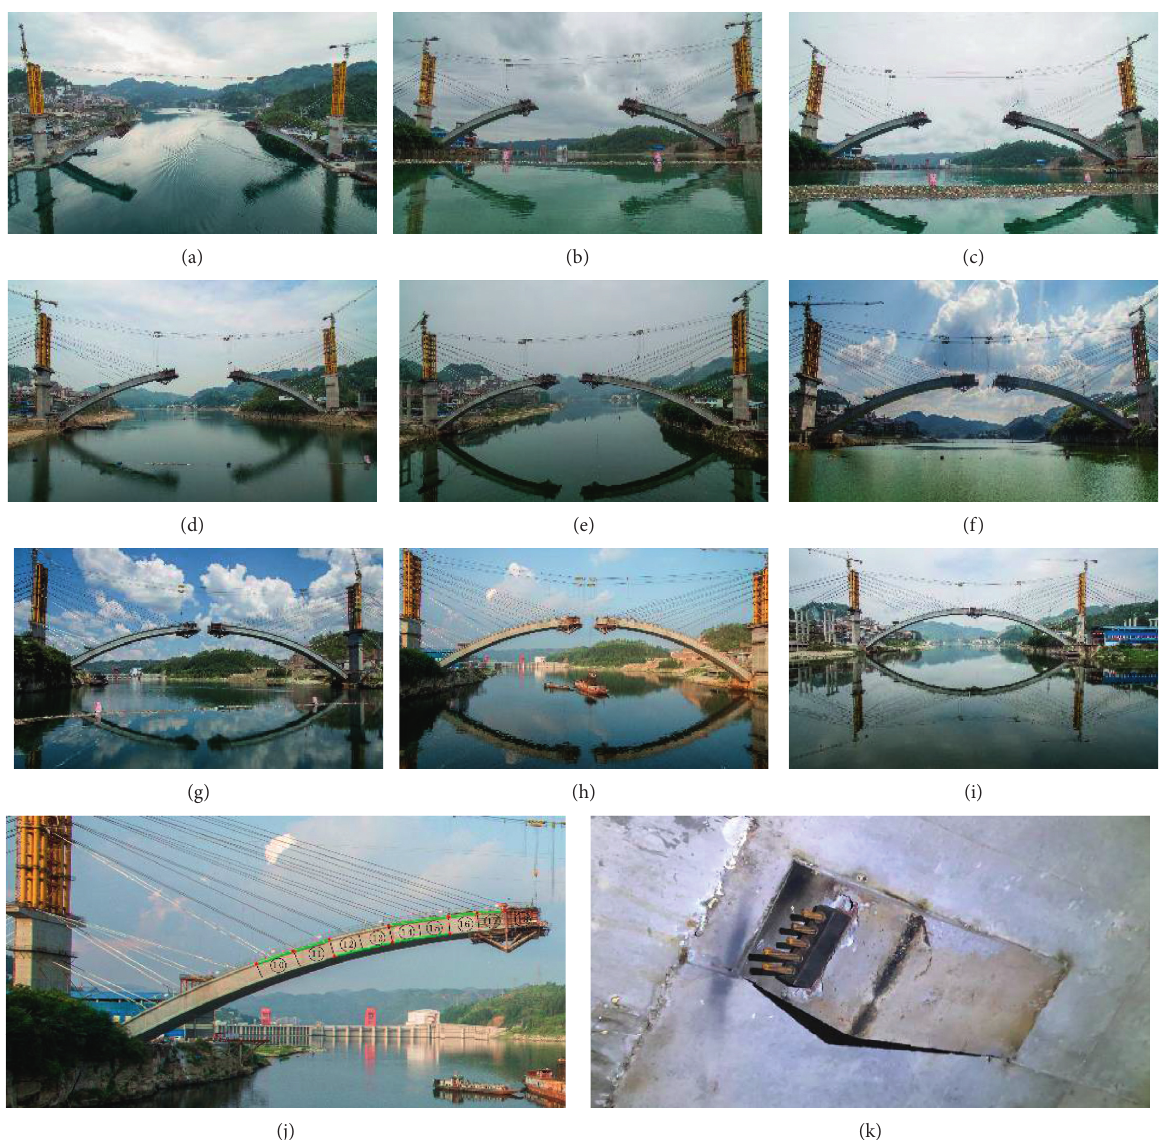
Figure 11: In-site erection procedure of the main arch ring of the Shatuo Bridge and tendon layout. (a) East no.10 and west no.10. (b) East no.12 and west no.13. (c) East no.13 and west no.13. (d) East no.14 and west no.14. (e) East no.16 and west no.16. (f) East no.17 and west no.16. (g) East no.18 and west no.16. (h) East no.18 and west no.17. (i) East no.18 and west no.18. (j) Tendon layout in the east coast in site. (k) Prestressed tension end in